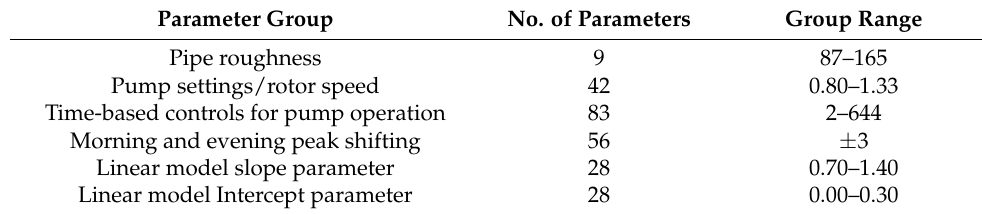
Table 1. Selected parameters to calibrate the hydraulic model. Parameter